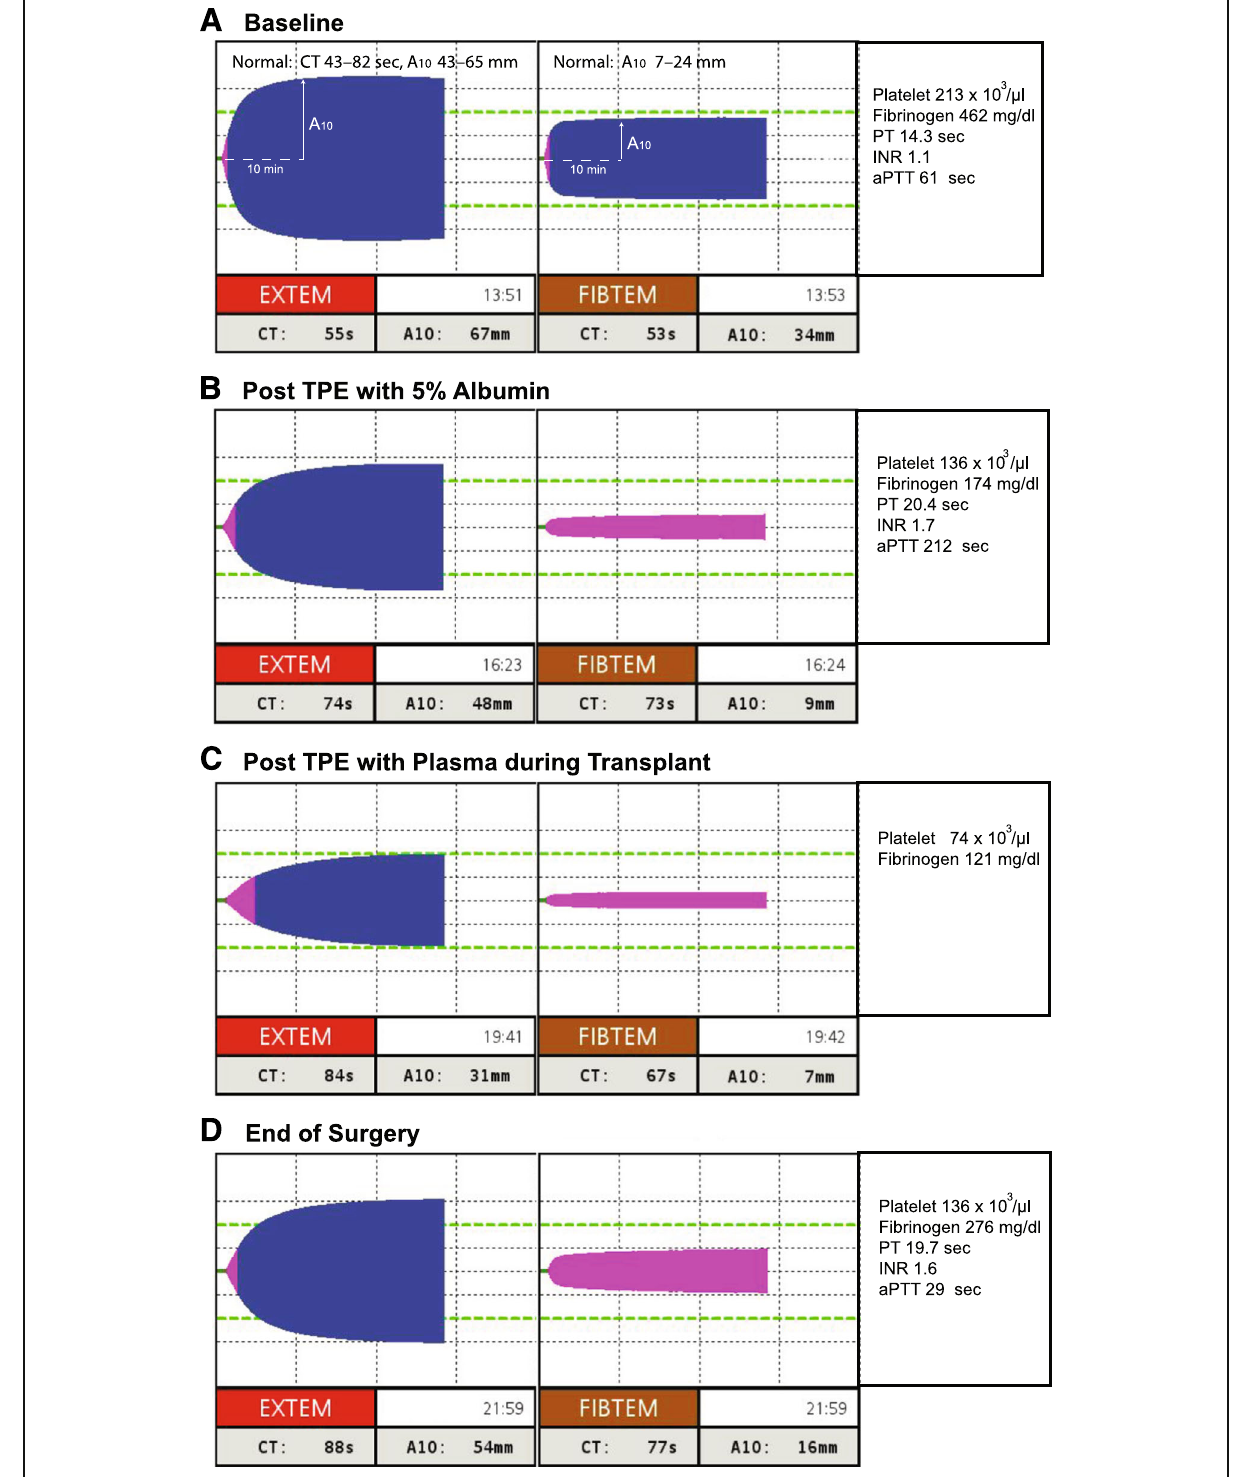
Fig. 1 a Key parameters of EXTEM-CT: clotting time (s) [normal, 43 – 82 s], EXTEM-A 10 : 10 min amplitude (mm) [normal, 43 – 65 mm], and FIBTEM-A 10 [normal, 9 – 24 mm]. b – d EXTEM and FIBTEM changes during and after therapeutic plasma exchange (TPE). Baseline fibrinogen was in supra-normal range ( b ), but it extensively decreased after TPE with albumin ( c ) and even after plasma replacement during surgery. Fibrinogen was restored only after the transfusion of cryoprecipitate ( d